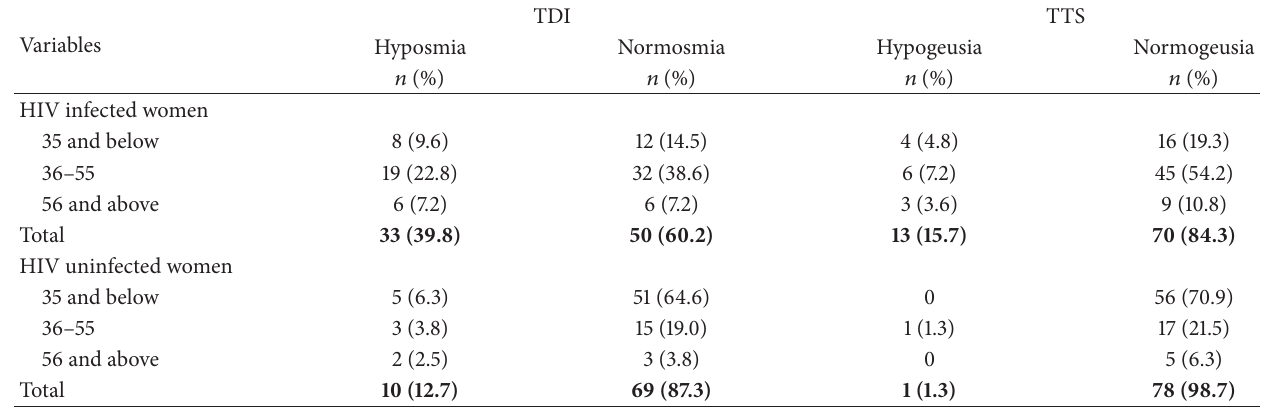
Table 3: Participants with hyposmia and hypogeusia.